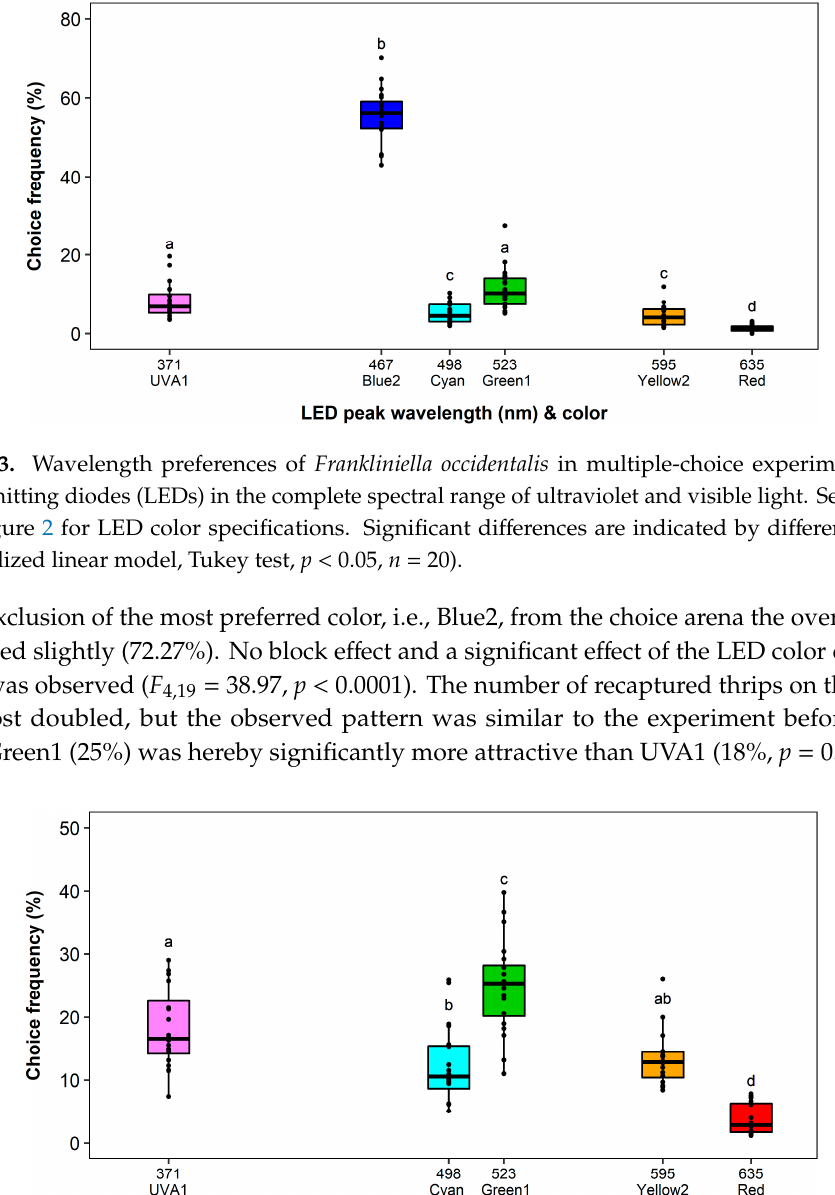
Figure 4. Wavelength preferences of Frankliniella occidentalis in multiple-choice experiment with light- emitting diodes (LEDs) in the complete spectral range of ultraviolet and visible light excluding blue. See Table 1 and Figure 2 for LED specifications. Significant differences are indicated by different letters (generalized linear model, Tukey test, p < 0.05, n = 20).